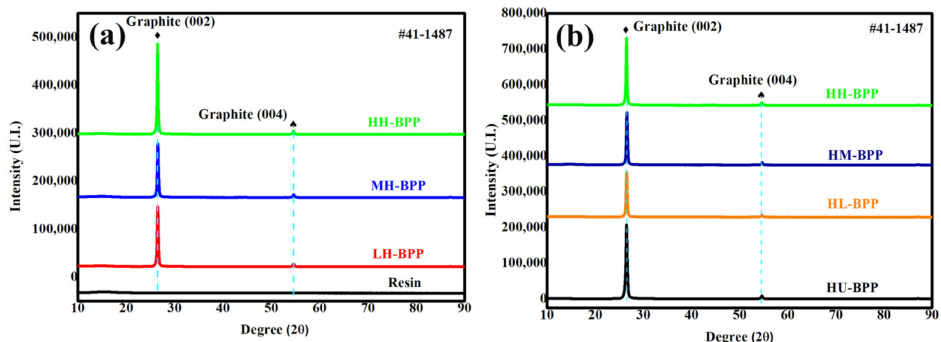
Figure 3. XRD spectra of composite BPs under ( a ) various molding pressures combined with high impregnation pressure and ( b ) high molding pressure combined with various impregnation pressures.